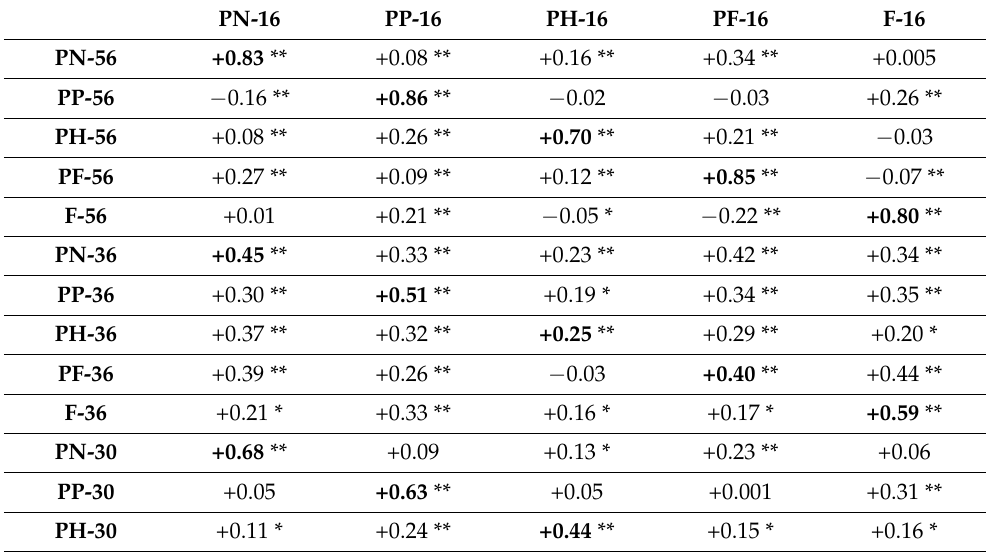
Figure 1. The five-factor model of the ZTPI-16 (N = 2295) with items in each factor structure. Table 2. The Pearson r correlation between every time perspectives of the ZTPI-16 and each subscale of the ZTPI-56, ZTPI-36, ZTPI-30, or ZTPI-22. In bold are the significant correlations between two corresponding time perspectives of different versions of the